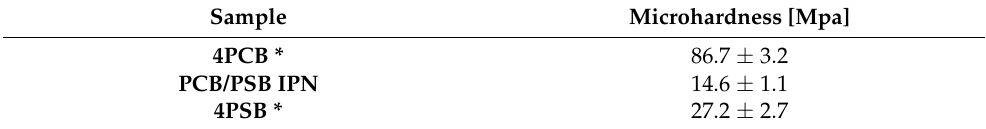
Table 1. Microhardness of dry PCB/PSB IPN, single 4PSB and 4PCB networks.